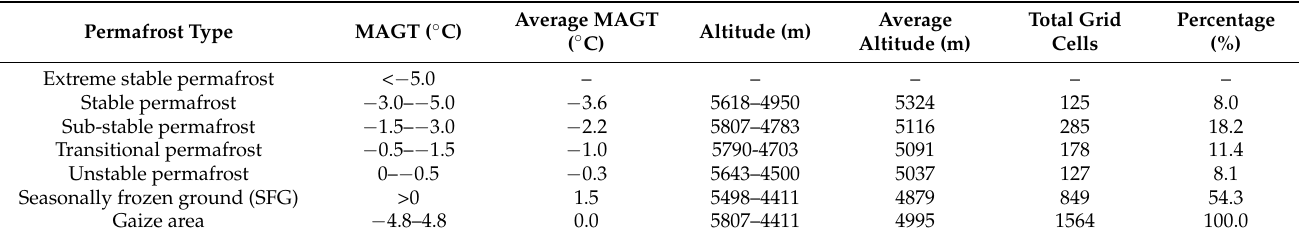
Table 5. MAGT, altitude, and total grid cell counts of each permafrost type in the Gaize area. Permafrost Type Extreme stable